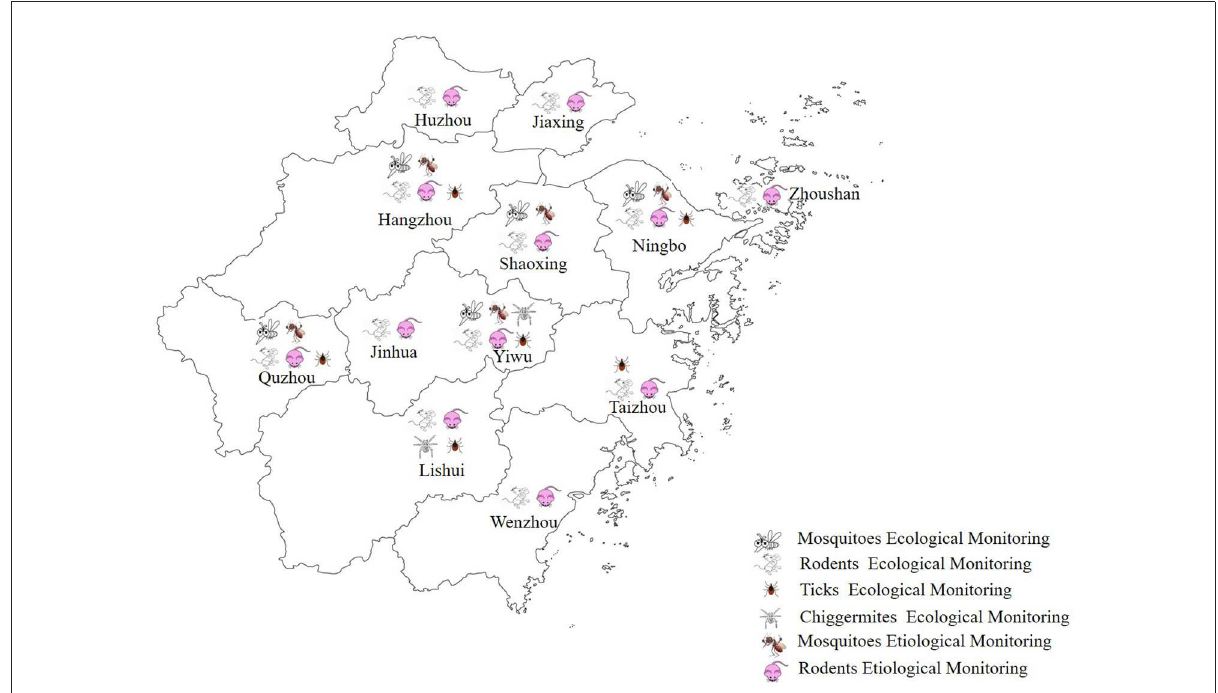
FIGURE1 A map of Zhejiang Province showing the locations of the 12 monitoring sites and the tasks conducted at these sites in the integrated surveillance system in 2020.